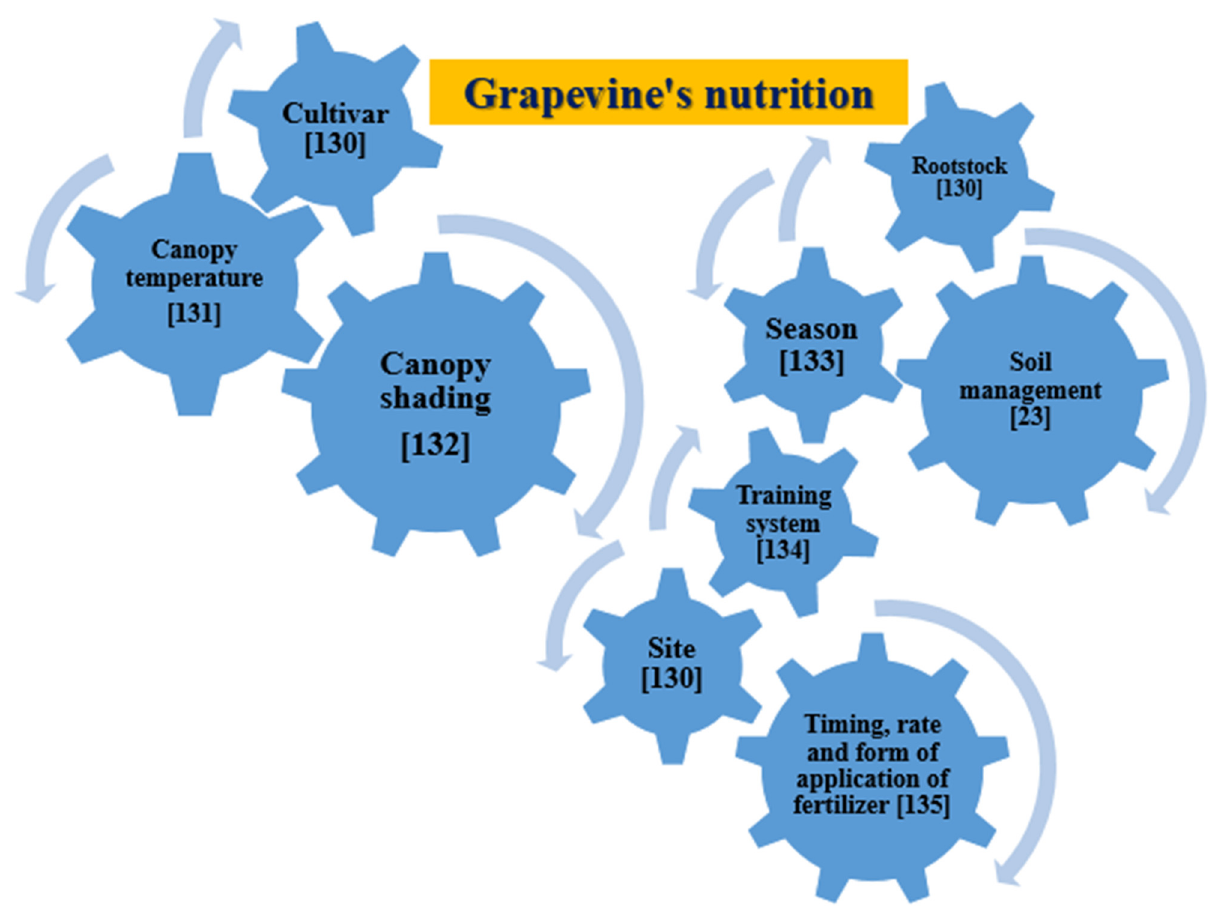
Figure 1. Interaction among factors that can affect the nutrition of the vineyard and call for a need to calibrate agronomic practice. The factors illustrated in the figure interact with each other and influence the nutritional and health status of the plant, which in turn affects the aromas of the berries.